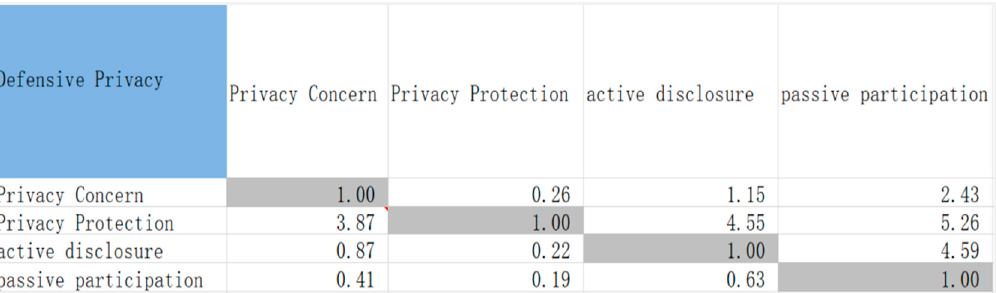
Figure 2. Case of constructing judgment matrix.